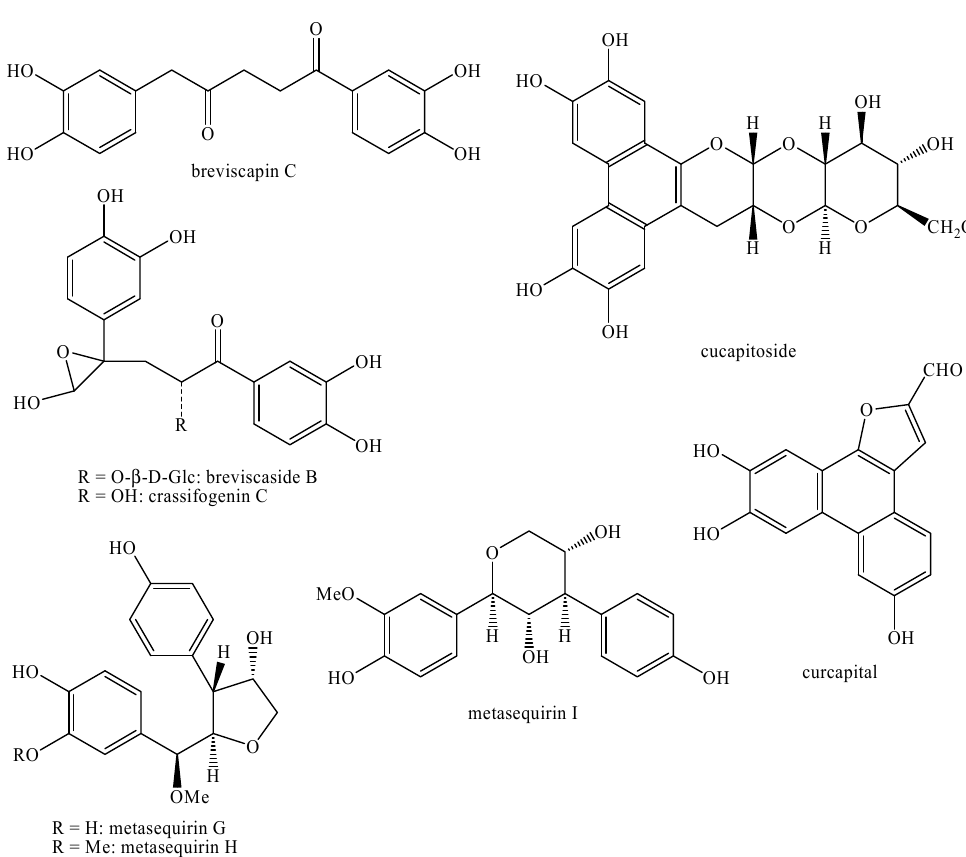
Figure 9. Isolated nor -lignans in the plant kingdom—part 8.